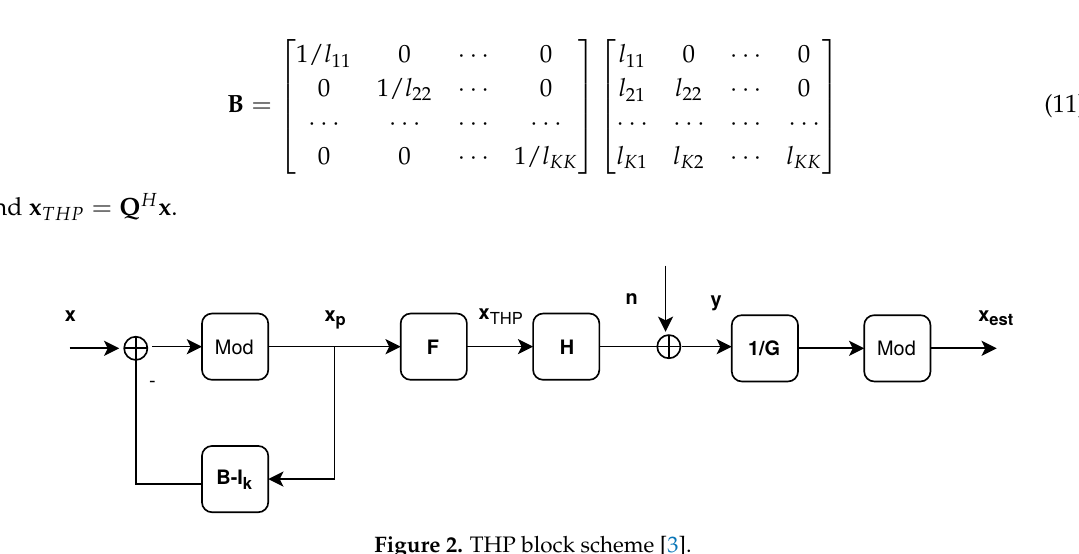
Figure 2. THP block scheme [3].